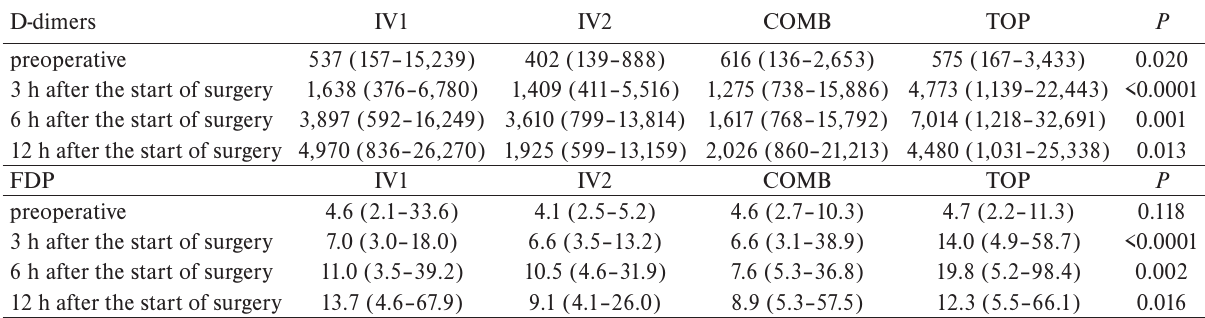
Table 3. Level of D-dimers and fibrin degradation products 3, 6 and 12 h after the start of surgery.